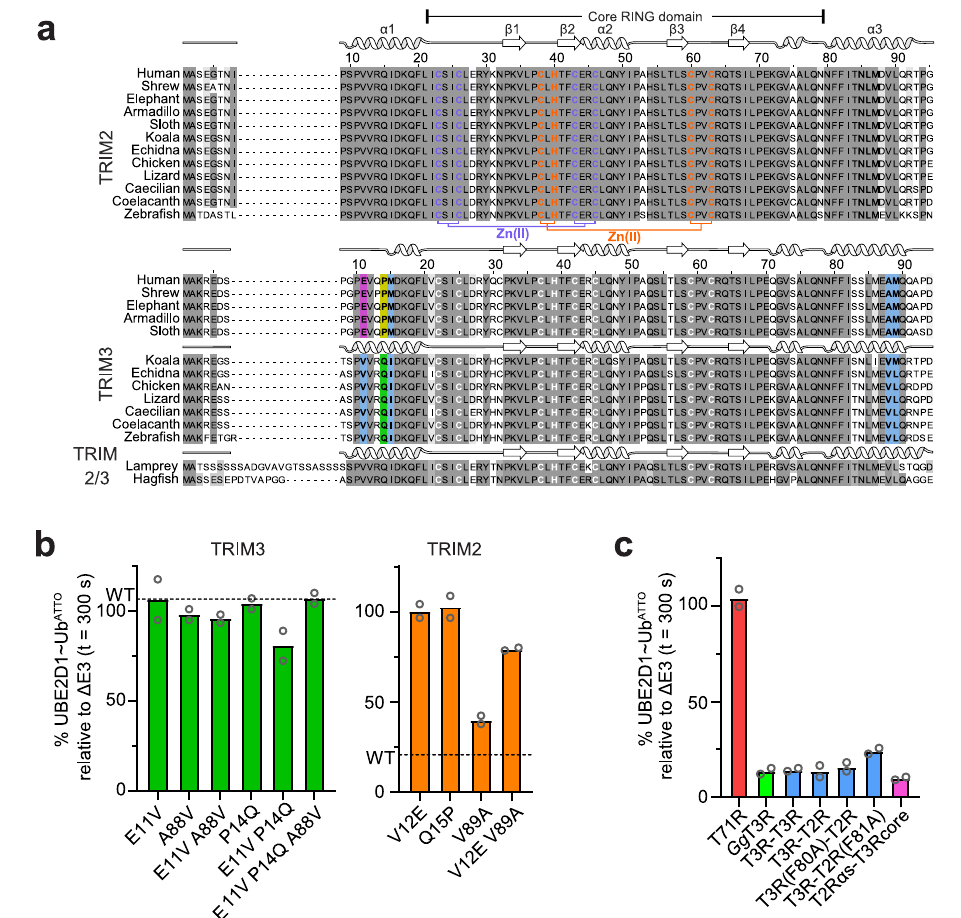
Fig. 5 | TRIM2/3 sequence conservation and rescuing activity of TRIM3. a Multiple sequence alignments of TRIM2 and TRIM3 RING domains across dif- ferent species. The secondary structures reported above the alignments are those of the crystal structure for TRIM2 RING in complex with UBE2D1~Ub and those predictedforTRIM3RINGfromdifferentspeciesbyAlphaFold2. b Quanti fi cationof theUBE2D1~Ub ATTO bandafter5-minreactiontimereportedasnormalizedintensity relativetotheexperimentintheabsenceofE3formutantconstructsofTRIM3and